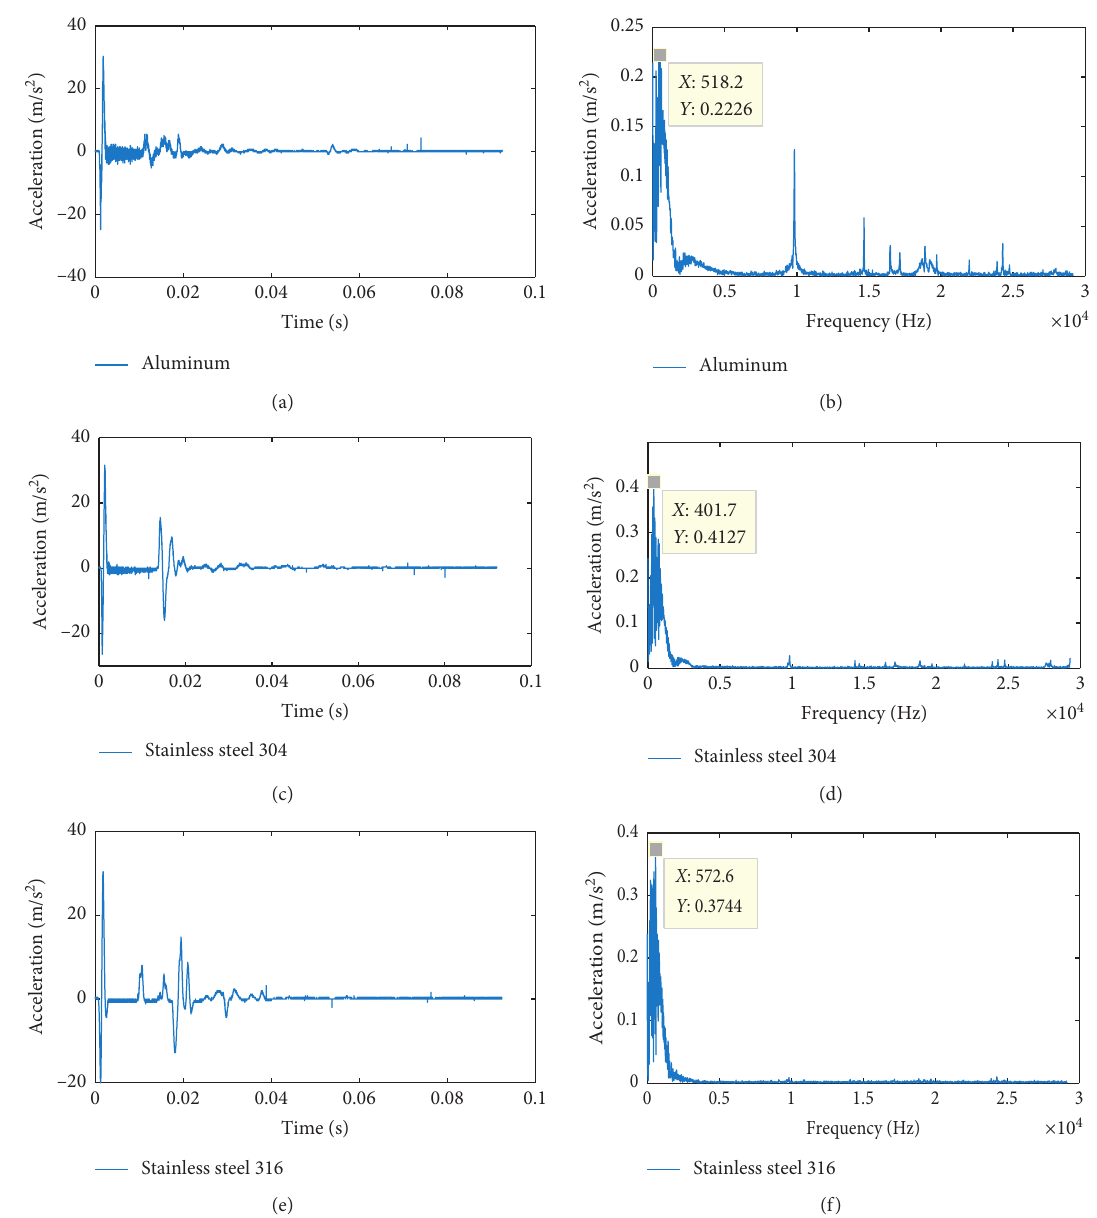
Figure 4: (a, c, e) Time-domain waveforms and (b, d, f) frequency spectra for different impacted metals.